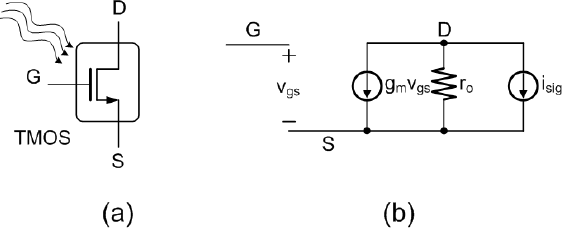
Figure 2. Equivalent NMOS transistor ( a ) symbol and ( b ) small-signal circuit